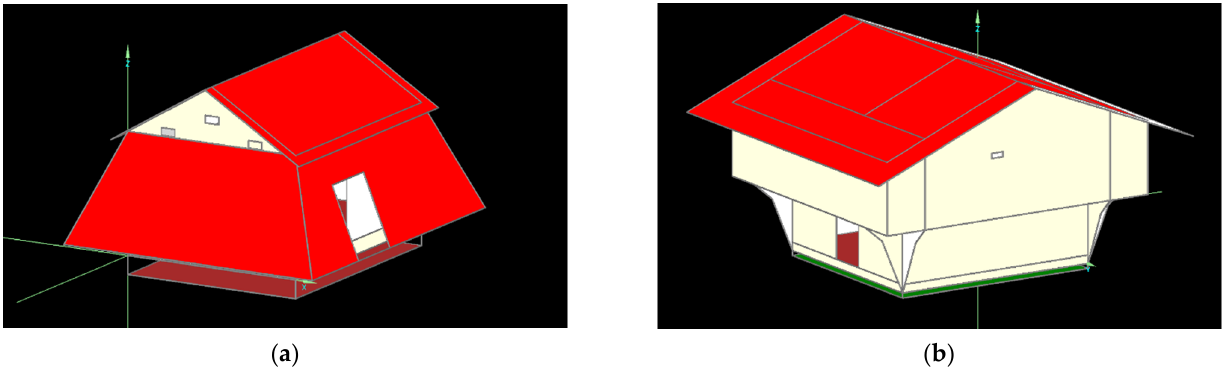
Figure 5. The whole-building simulation models of ( a ) the Fadum storehouse and ( b ) the Heierstad loft.